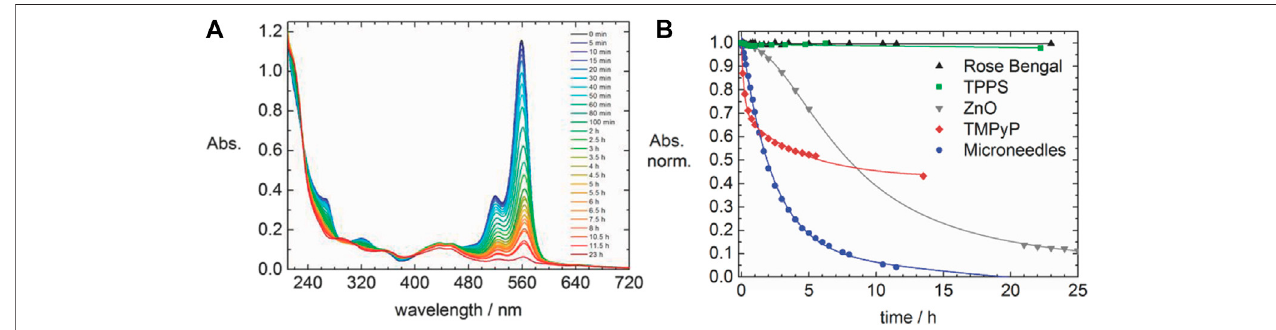
FIGURE 29 | Photodegradation of Rose Bengal by porphyrin-porphyrin microrhombuses decorated with ZnO nanorods: (A) Time-dependent UV/Vis spectroscopyofthedegradation ofRoseBengalwiththeZnOmicrorhombuses. (B) Catalytic degradationofRoseBengalwithZnO-microrhombuses (bluecircles),with TMPyP(redrhombs),withTPPS(greensquares),withZnO-nanorods(grayinverted triangles),andwithoutcatalyst(black triangles)(Düringetal.,2017b).Reprinted with permission. Copyright © 2017 WILEY-VCH Verlag GmbH and Co. KGaA,